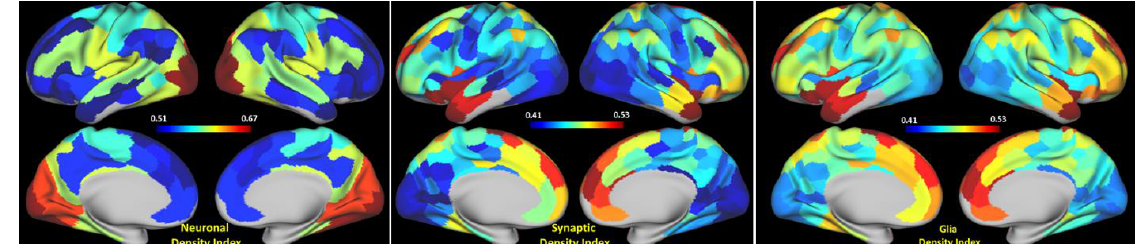
Figure 2. Surface maps of neuronal, glia, and synaptic density indices (qGRE proxy for the neuronal, synaptic, and glia